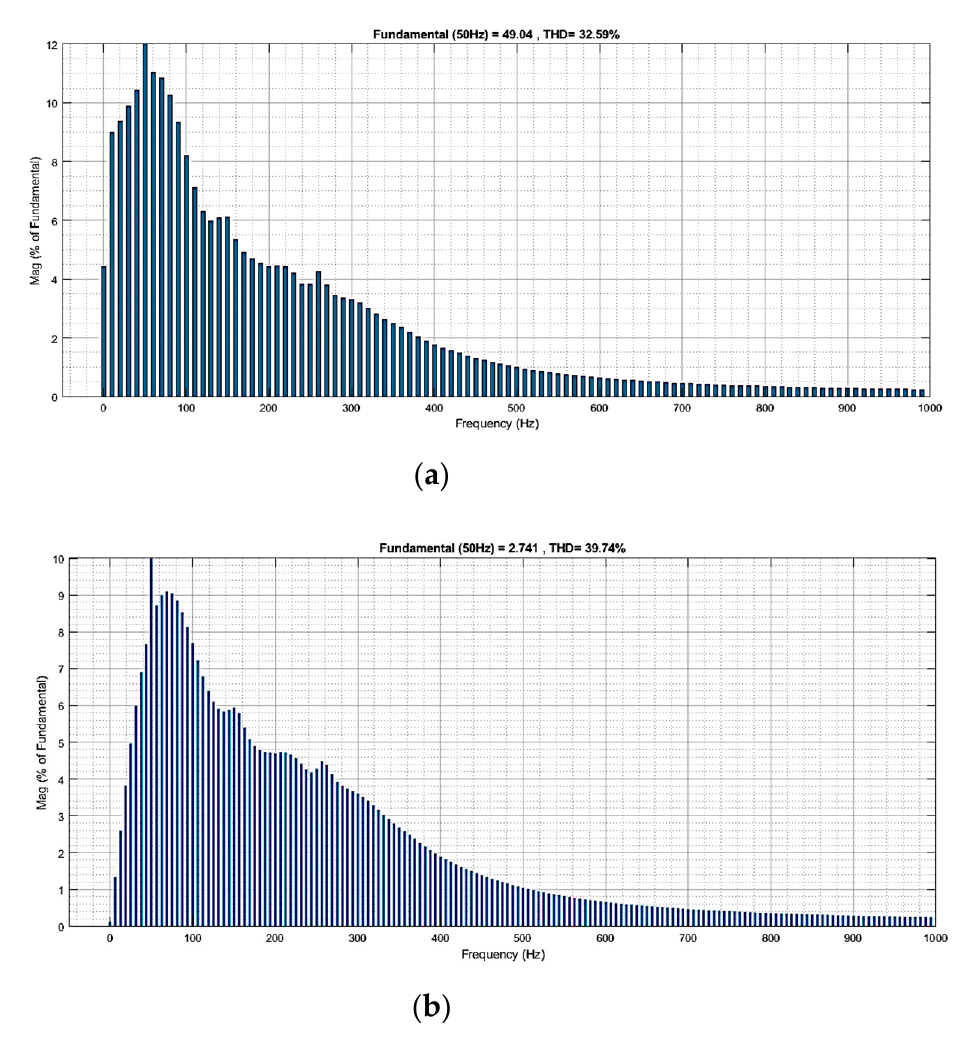
Figure 12. The THD values of output voltage and current for the inverter with ZSC, ( a ) voltage waveform, and ( b ) current waveform.